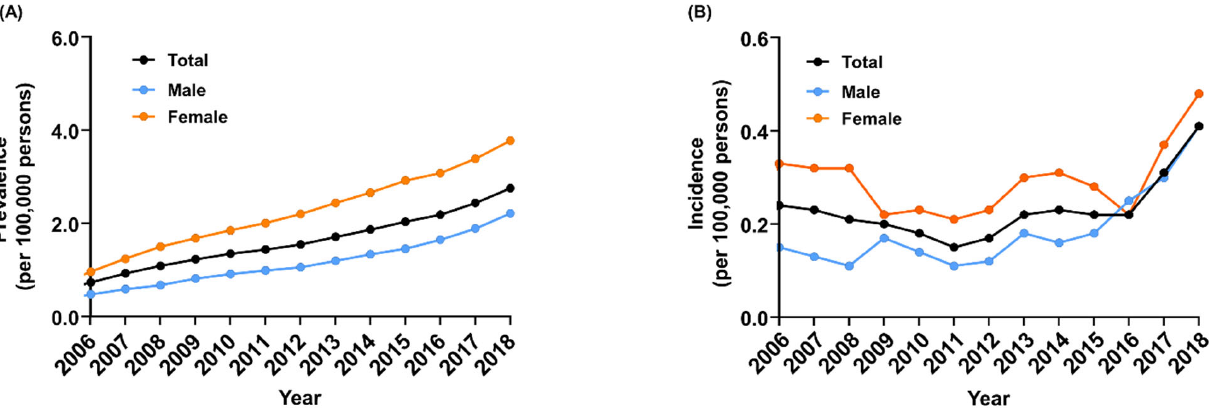
Figure 1. The ( A ) prevalence and ( B ) incidence of thalassemia in Korea, 2006–2018.